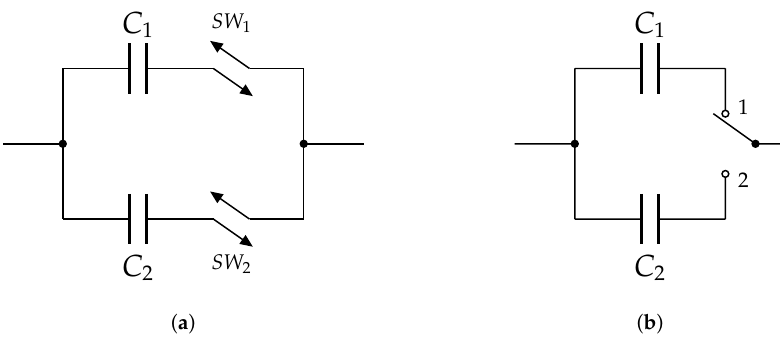
Figure 1. A switched capacitor with: ( a ) two switches; and ( b ) one ideal single-pole double-throw switch.